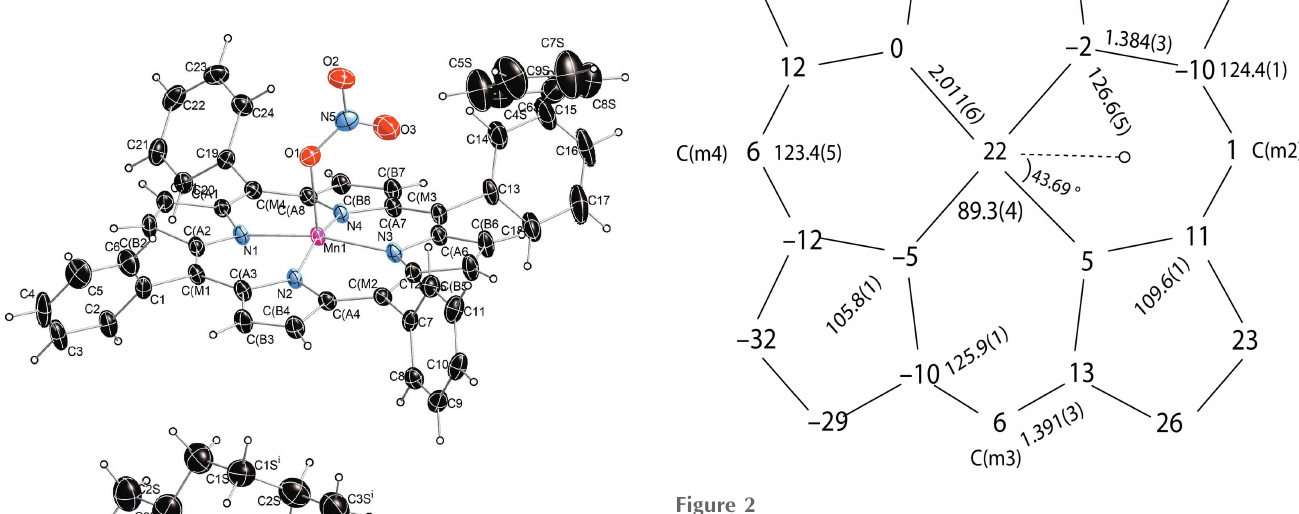
Figure 2 A formal diagram of the porphyrin core of the title compound. Averaged values of the chemically unique bond lengths (A˚ ) and angles ( (cid:4) ) are shown. The perpendicular displacements (in units of 0.01 A˚ ) of the porphyrin core atoms from the 24-atom mean plane are also displayed. The positive numbers indicate a displacement towards the nitrate ligand, the dashed line indicates the plane of the nitrate ligand on the unhindered porphyrin side.